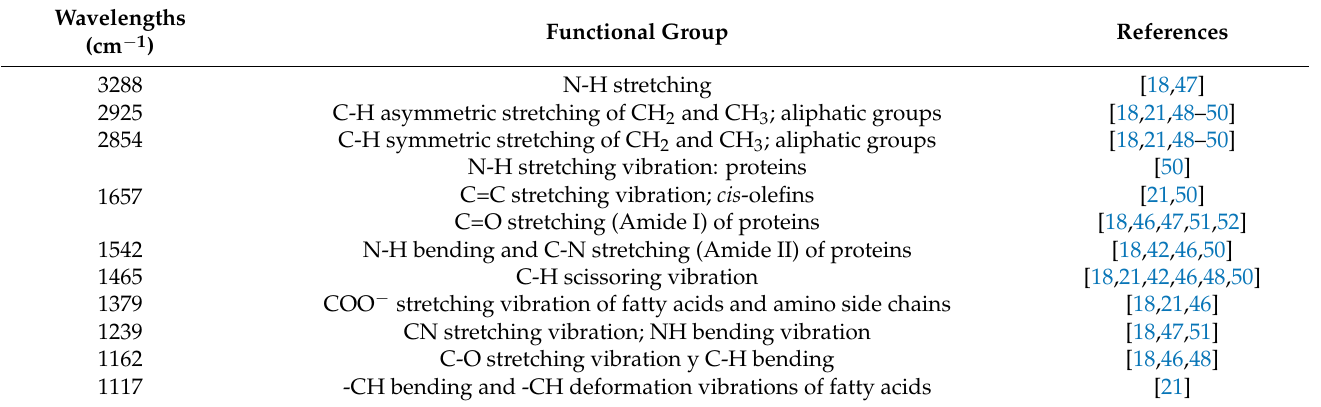
Table A1. Wavenumber assignment with the chemical functional